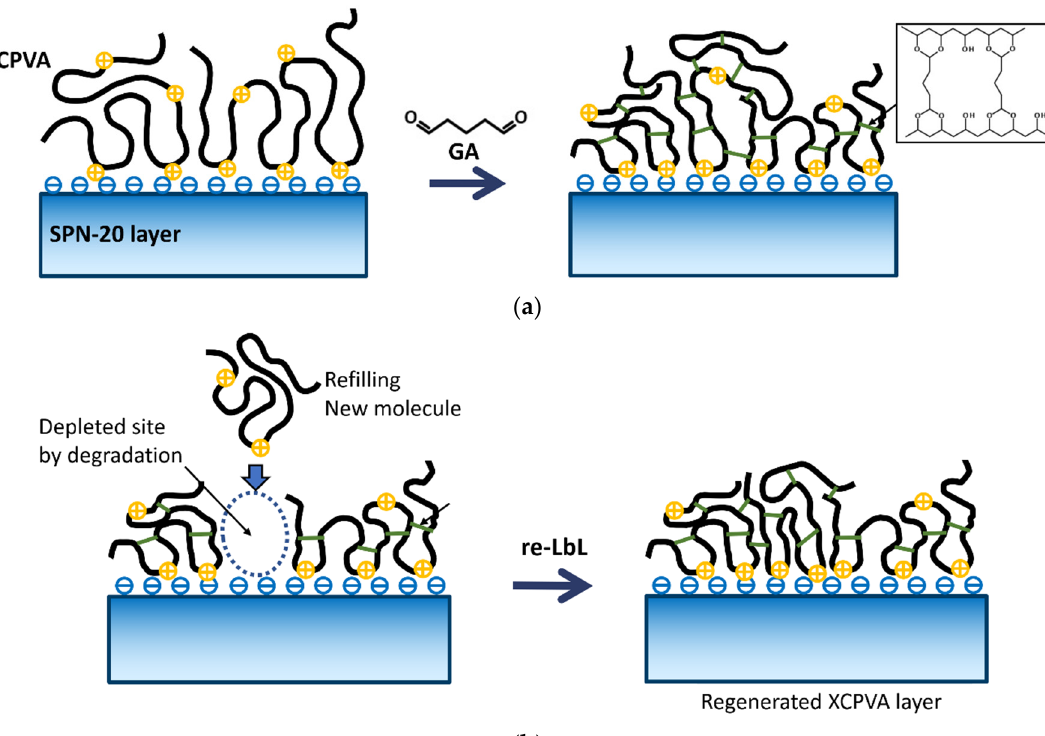
Figure 13. The proposed mechanism of adsorption and cross-linking of low-charge CPVA copolymers on anionic SPN-20 surfaces. ( a ) Initial adsorption of CPVA on SPN-20 followed by glutaraldehyde (GA) cross-linking. The inset shows the cross-linked PVA structure which forms 1,3-dioxane rings bridged by C3 spacers. ( b ) Regeneration by repeated LbL (re-LbL) treatment in which the depleted sites of XCPVA layer are refilled by new CPVA molecules via electrostatic interactions. Subsequent cross-linking restores the XCPVA layer to a state similar to the virgin membrane.